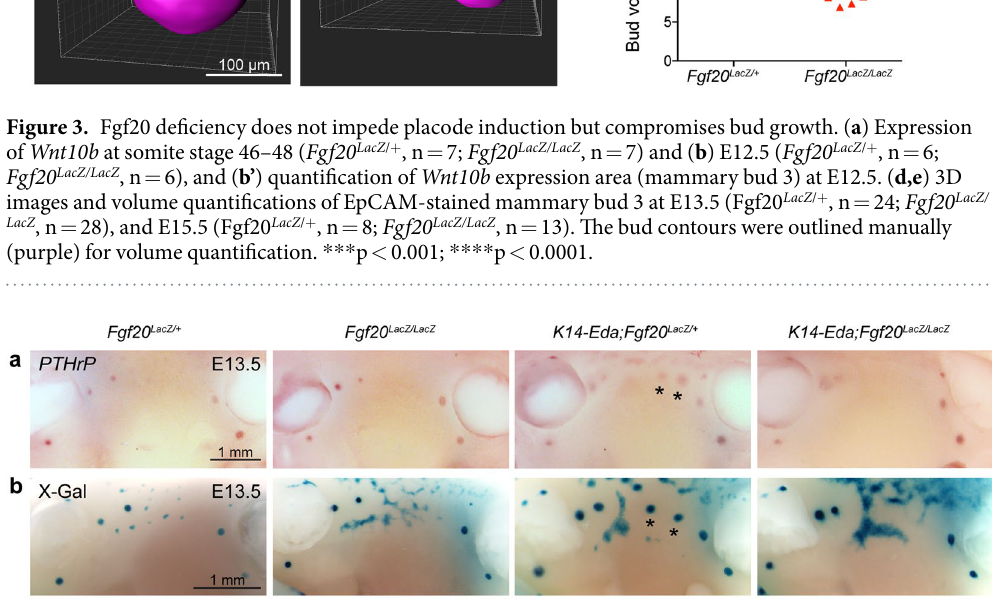
Figure 4. Fgf20 deficiency delays induction of supernumerary buds in K14- Eda mice. ( a ) Expression of PTHrP at E13.5 ( Fgf20 LacZ / + , n = 4; Fgf20 LacZ/LacZ , n = 4; K14- Eda;Fgf20 LacZ / + , n = 7; K14- Eda;Fgf20 LacZ/LacZ , n = 5), and ( b ) X-gal staining of Fgf20-LacZ at E13.5 ( Fgf20 LacZ/ + , n = 4; Fgf20 LacZ/LacZ , n = 6; K14- Eda;Fgf20 LacZ/ + , n = 11; K14- Eda;Fgf20 LacZ/LacZ , n = 8). Supernumerary placodes (stars) were detected between buds 3 and 4 in K14- Eda ;Fgf20 LacZ/ + embryos at E13.5, but not in K14-Eda;Fgf20 LacZ/LacZ